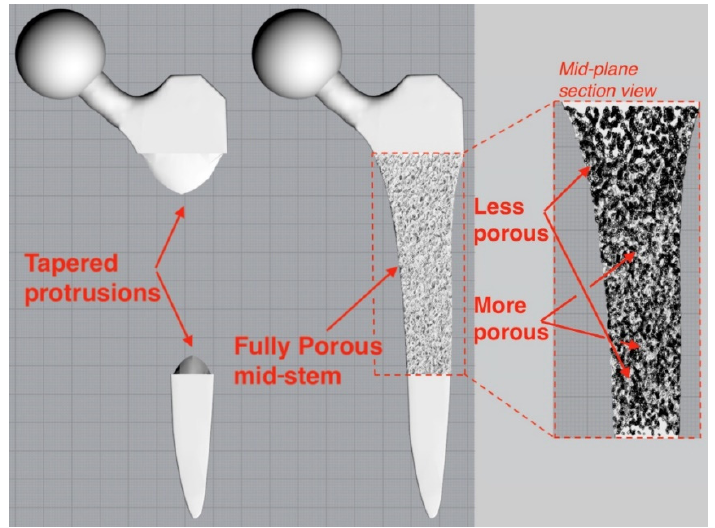
Figure 2. Tapered protrusions (left) enabled a gradual transition between the porous and solid regions of the porous implant